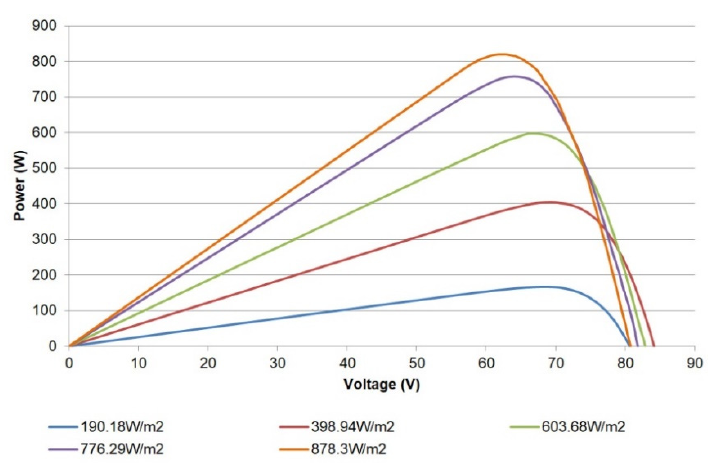
Figure 21. P ‐ V curves of PV generator. Figure 21. P-V curves of PV